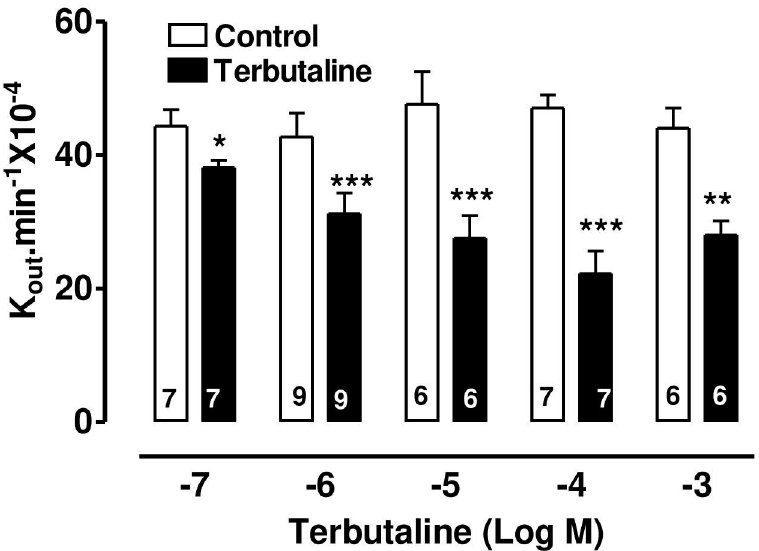
Fig 1. The effect of terbutaline on AH formation rate in the bovine isolated perfused eye measured by fluorescein dilution technique. AH formation rate was expressed as the rate constant (K out .min -1 × 10 − 4 ), defined as the slope of the regression line drawn on LN (Log e ) of the changes of fluorescence with time (min). Each value is a mean s.e.mean of the number (n) of experiments shown at the base of each column. In order to eliminate individual variation, control and treated data were obtained from the same eye. AH formation rate measured during the first 30 min prior to drug application was taken as the control value. AH formation rate for the subsequent 40–60 min after establishment of drug effects was taken as the treated value. Note that after addition of drug, 20 min stabilization period was allowed to establish drug effect. Significance of differences from controls; � p < 0.05, �� p < 0.01 and ��� p <